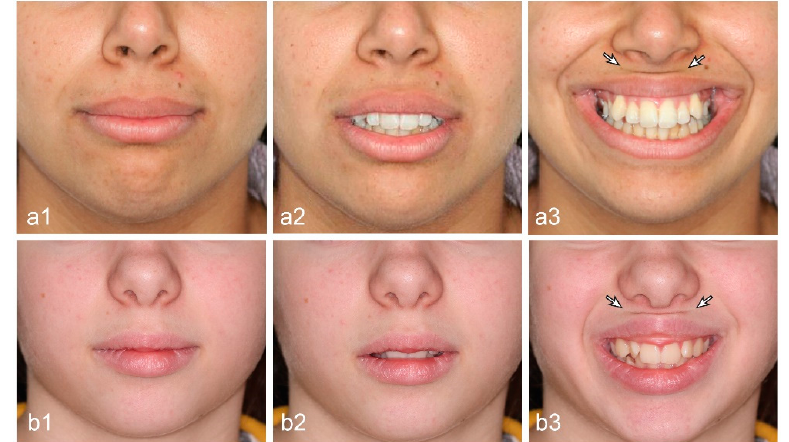
Figure 1. En-face view of two patients ( a , b ) with upper lip horizontal line (ULHL). ( a1 , b1 ): No presence of ULHL at lip together; ( a2 , b2 ): no presence of ULHL at rest; ( a3 , b3 ): full presence of ULHL at smile (see arrow). Note the flip of the upper lip during full smile.